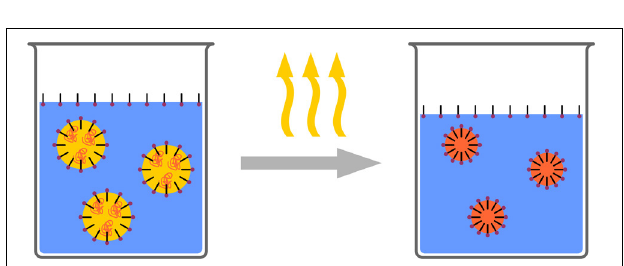
FIGURE 7 | Schematic representation of the solvent evaporation process. A polymer solution is formulated as a surfactant stabilized emulsion. Subsequently the solvent is evaporated resulting in polymeric